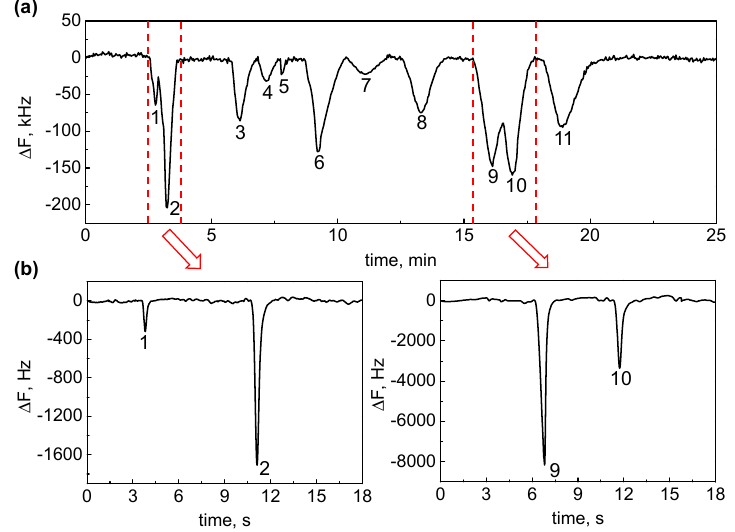
Figure 7. ( a ) Real–time response of eleven gases detected by 1D GC. 1: Ethanol; 2: DCH; 3: Acetone; 4: TCH; 5; Hexane; 6: Benzene; 7: Toluene; 8: Heptane; 9: DMMP; 10: DIMP; 11: MS. The proportion of the eleven analytes was 0.3 µ L: 0.45 µ L: 0.3 µ L: 0.1 µ L: 0.1 µ L: 0.3 µ L: 0.1 µ L: 0.1 µ L: 0.05 µ L: 0.05 µ L: